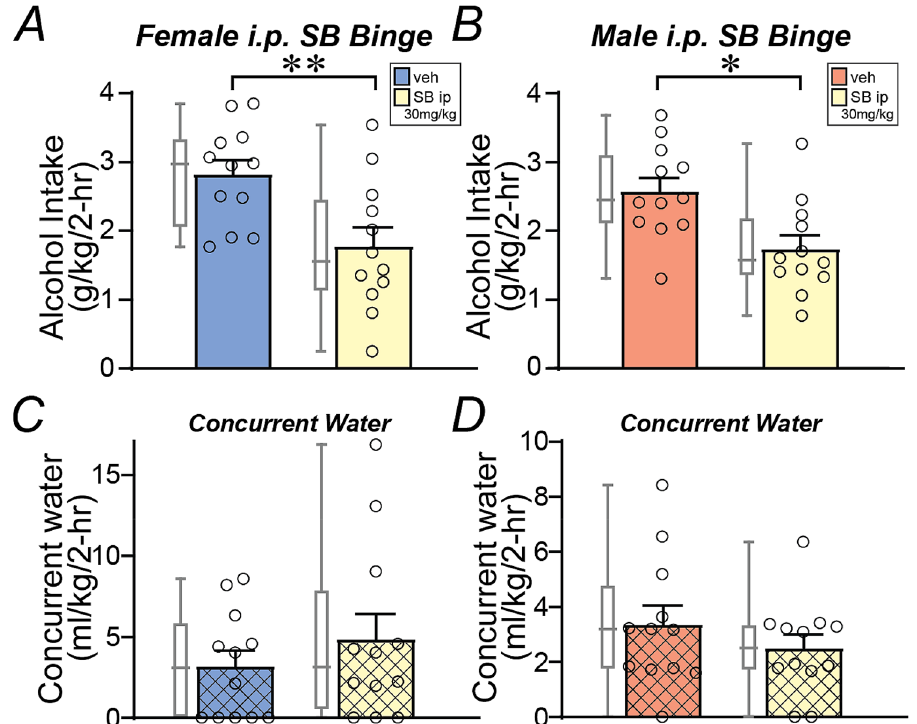
Figure 2. Higher doses of systemic Ox1R inhibitor reduced alcohol-only drinking in both sexes. ( A , B ) Higher dose SB (30 mg/kg) given systemically reduced alcohol-only drinking in both ( A ) females and ( B ) males. ( C , D ) Systemic SB at this dose did not reduce concurrent water intake in either sex. * p < 0.05; ** p <